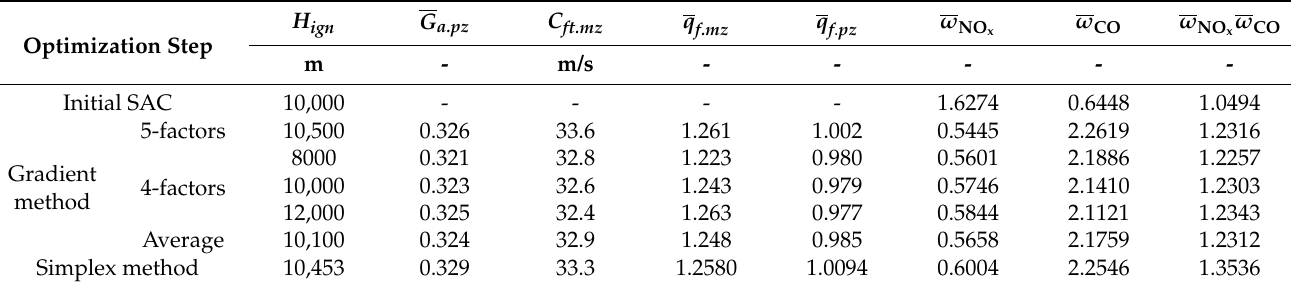
Table 7. Results of optimization methods.